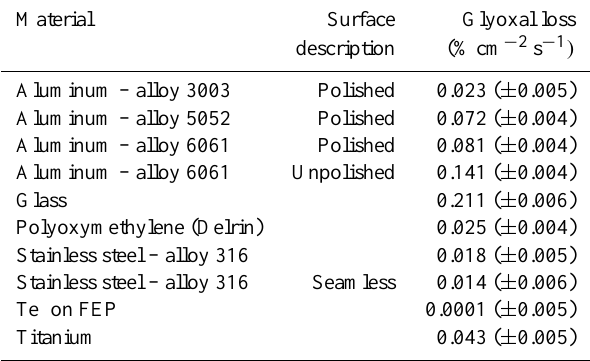
Table 2. Glyoxal losses measured for different tubing